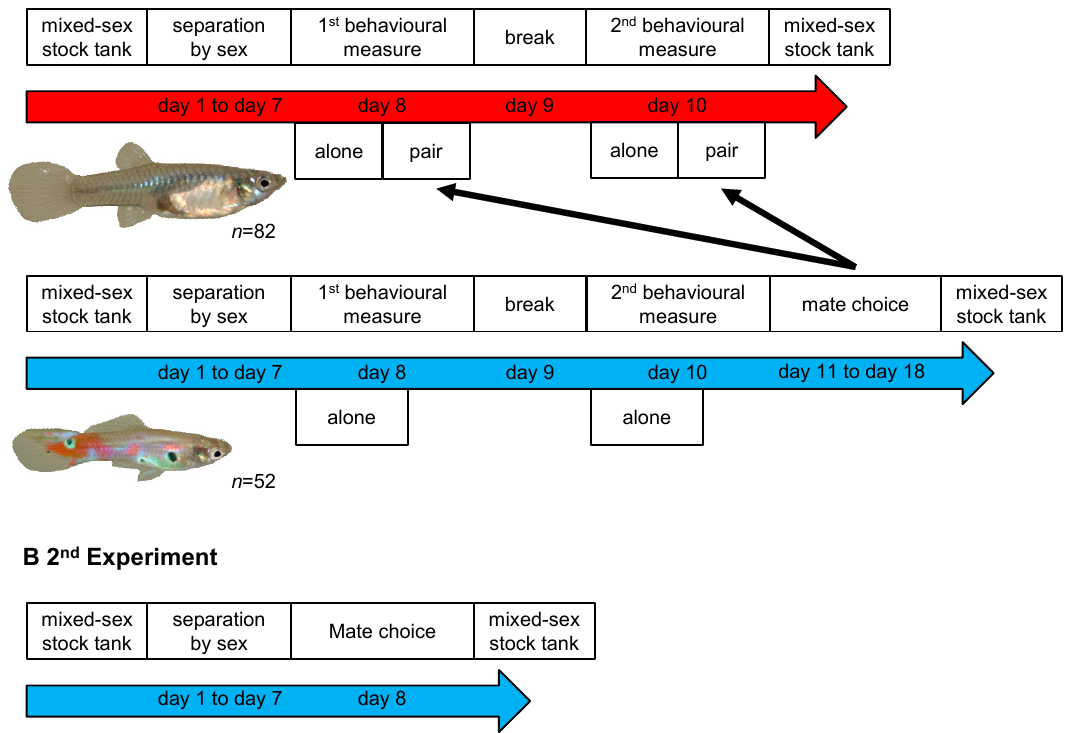
activity test, this two-phase test was repeated after 48 h with another